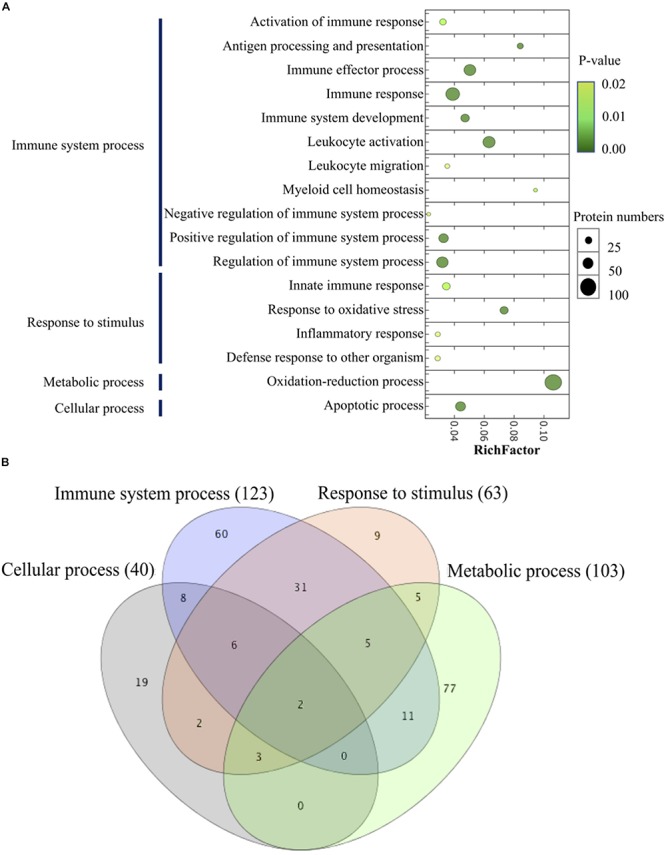
Scatter plot of GO enrichment analyses (A) and hierarchical clustering (B) of differentially abundant proteins related to immune system process. The Y-axis is different GO functions. The X-axis is the value of rich factor (p-value of Fisher exact test < 0.05). The color of circles stands for the p-value of function. The size of circles stands for protein numbers.